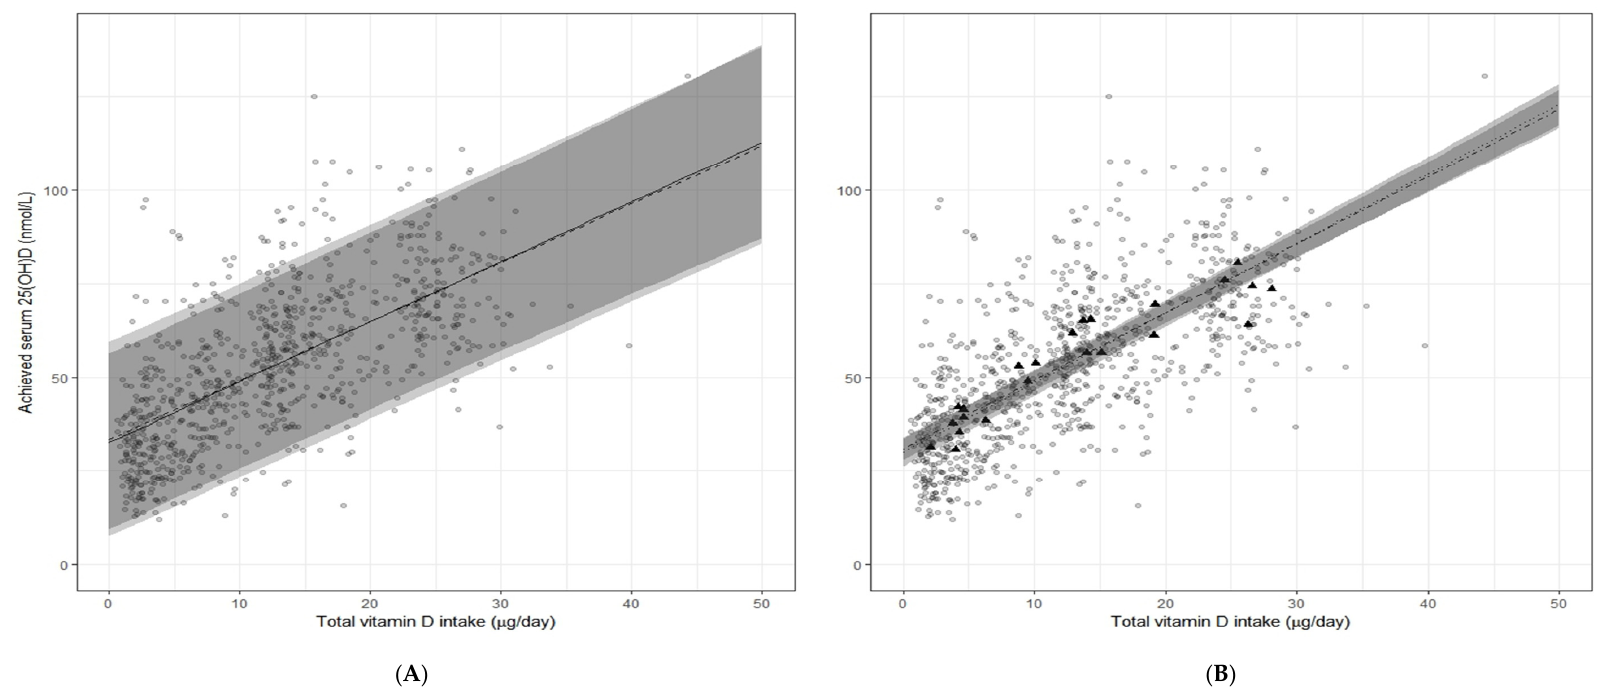
Figure 1. The relation between serum 25-hydroxyvitamin D (25(OH)D) concentrations (in late winter) and total vitamin D intake (i.e., from diet plus supplemental) in healthy persons aged 4–86 years living at northerly latitudes (between 51° N and 60° N) based on individual participant data (IPD) ( n = 882 individuals) ( A ) and aggregate RCT group mean data ( n = 23 arms) ( B ) from the same RCTs. The solid and dashed lines through the IPD data points (black circles) ( A ) correspond to the fitted regression lines based on the two ‐ step (adjusted for age and baseline 25(OH)D) and one ‐ step IPD analyses, respectively, and the corresponding 95% prediction bands are shown in grey (the lightest being the band for the one ‐ step IPD analysis) ( A ). The fitted regression lines for the unadjusted and adjusted (age and baseline 25(OH)D) standard meta ‐ regression based on aggregate data from same RCTs (black triangles) ( B ) are shown as dotted and dot ‐ dashed lines with corresponding 95% confidence bands shown in grey (the lightest being the band for the unadjusted analysis).